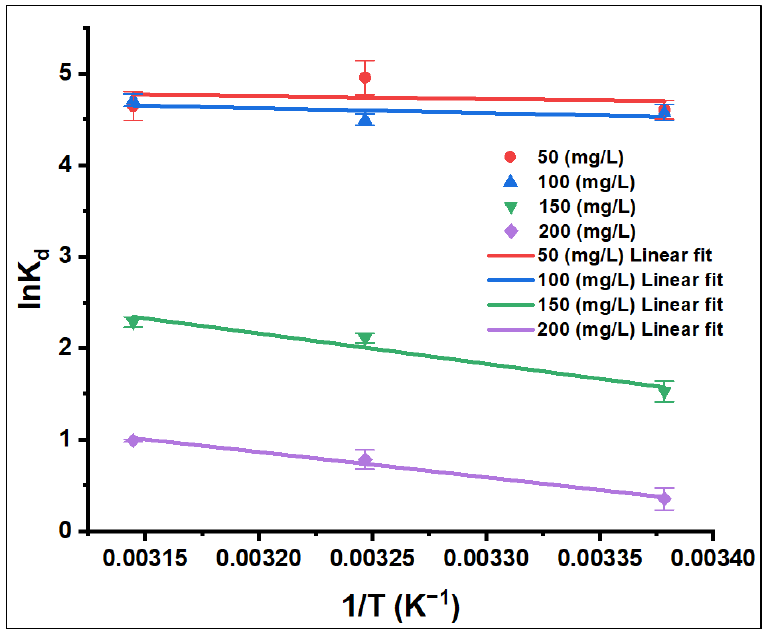
Figure 12. Effect of temperature on the adsorption of CV onto ZFAC. Bars represent the standard error of the mean ( n = 2).